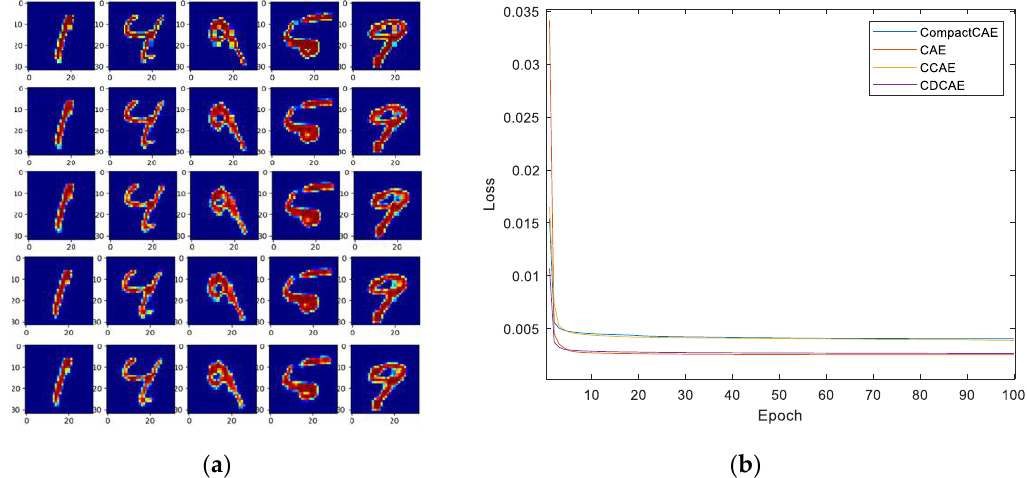
Figure 6. Validation Experiments with the mixed national Institute of standards and technology database (MNIST) dataset. ( a ) The reconstruction results of the baseline convolution auto-encoder (CAE), the CAE with the compact depth-wise separable convolution (CSeConv) layer (CCAE), the CAE with the compact separable deconvolution (CSeDeConv) layer (CDCAE), and the compact CAE with the CSeConv layer and CSeDeConv layer (CompactCAE) from the top row to the bottom row. ( b ) The training losses of the four